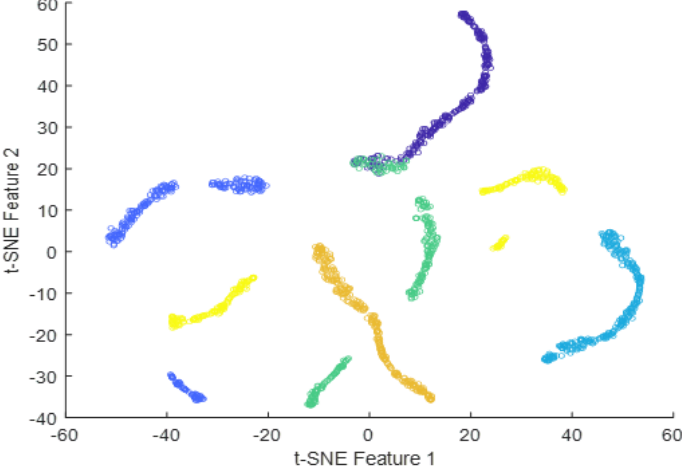
Figure 18. t-SNE plot of the extracted features from the fully-connected layer for